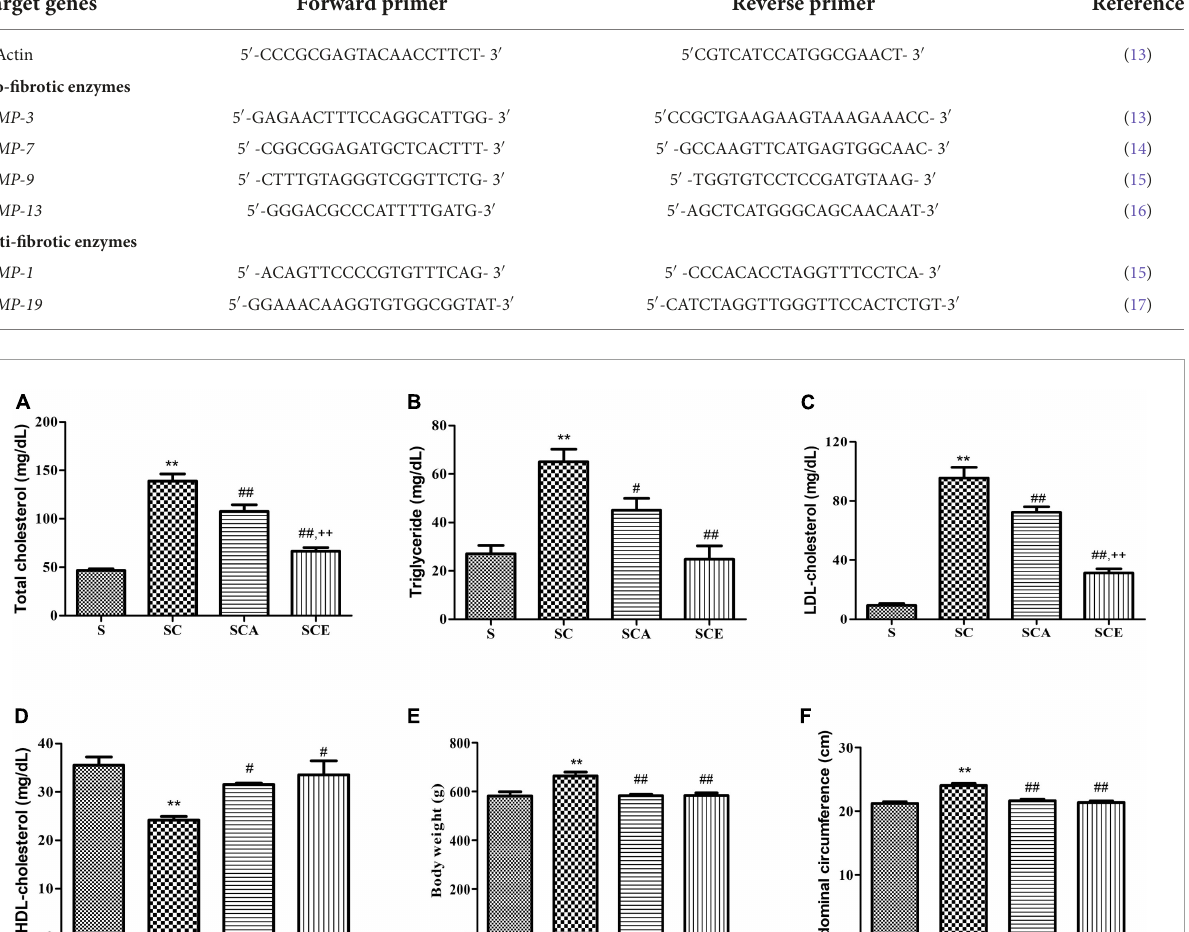
TABLE 1 Primer sequences for quantitative reverse transcription-PCR.